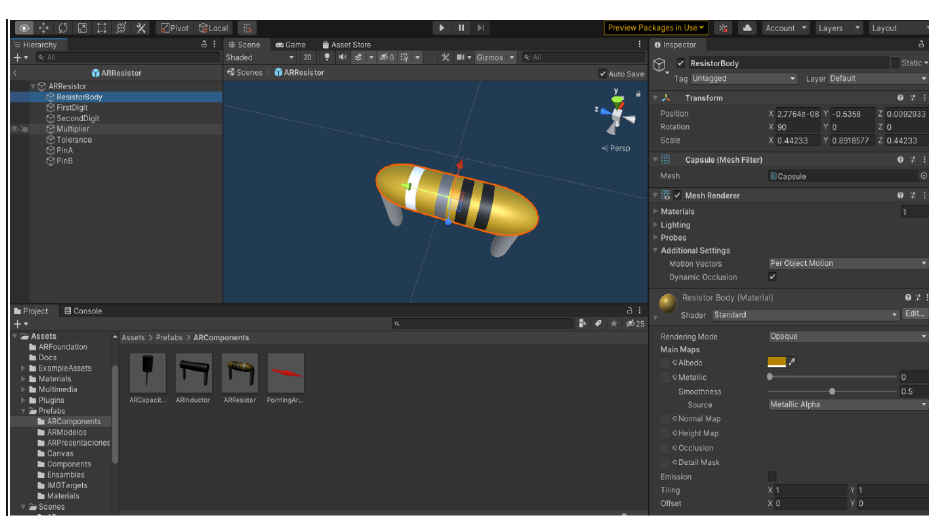
Figure 4. AR—resistor